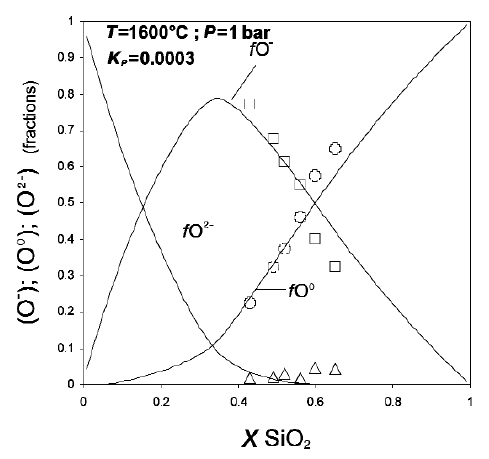
Fig. 8. XPS measurements of oxygen speciation in quenched CaO-SiO 2 melts (after Park and Rhee, 2001), compared with EPA predictions (Ottonello,